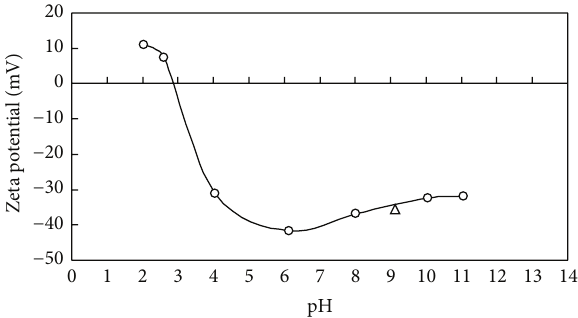
Figure 4: Zeta potentials of M-PVAL at various pH values. I and △ : pH values of aqueous solutions containing M-PVAL are ( 1 ) controlled with addition of HCl or NaOH and ( 2 ) not